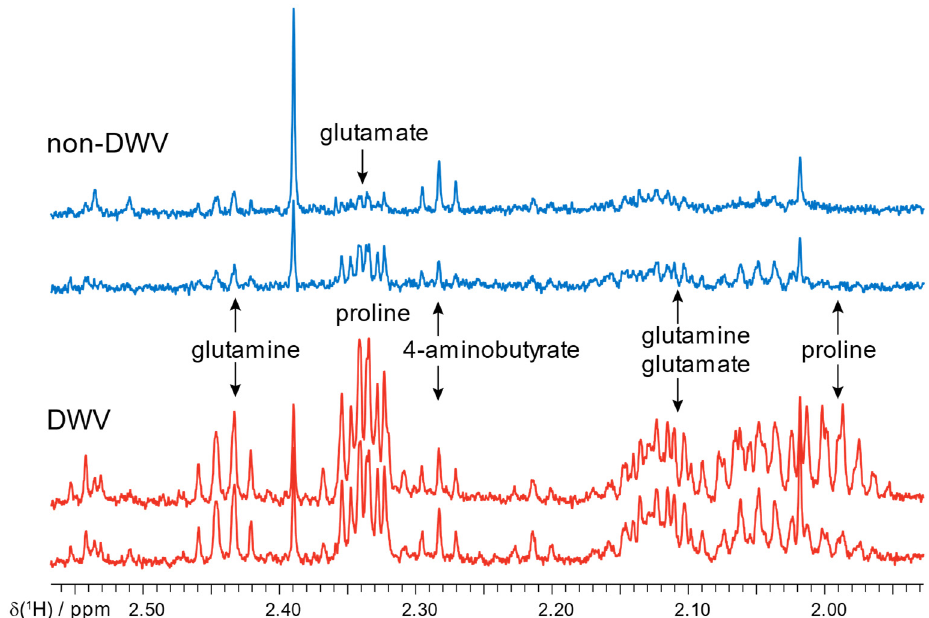
Figure 6. Representative spectra of extracted metabolites of forager brains with and without DWV show a particularly strong difference in the amount of proline, [15] although glutamine and glutamate are weakly suggested. In contrast, changes in 4-aminobutyrate (GABA), an important neurotransmitter, were not supported.